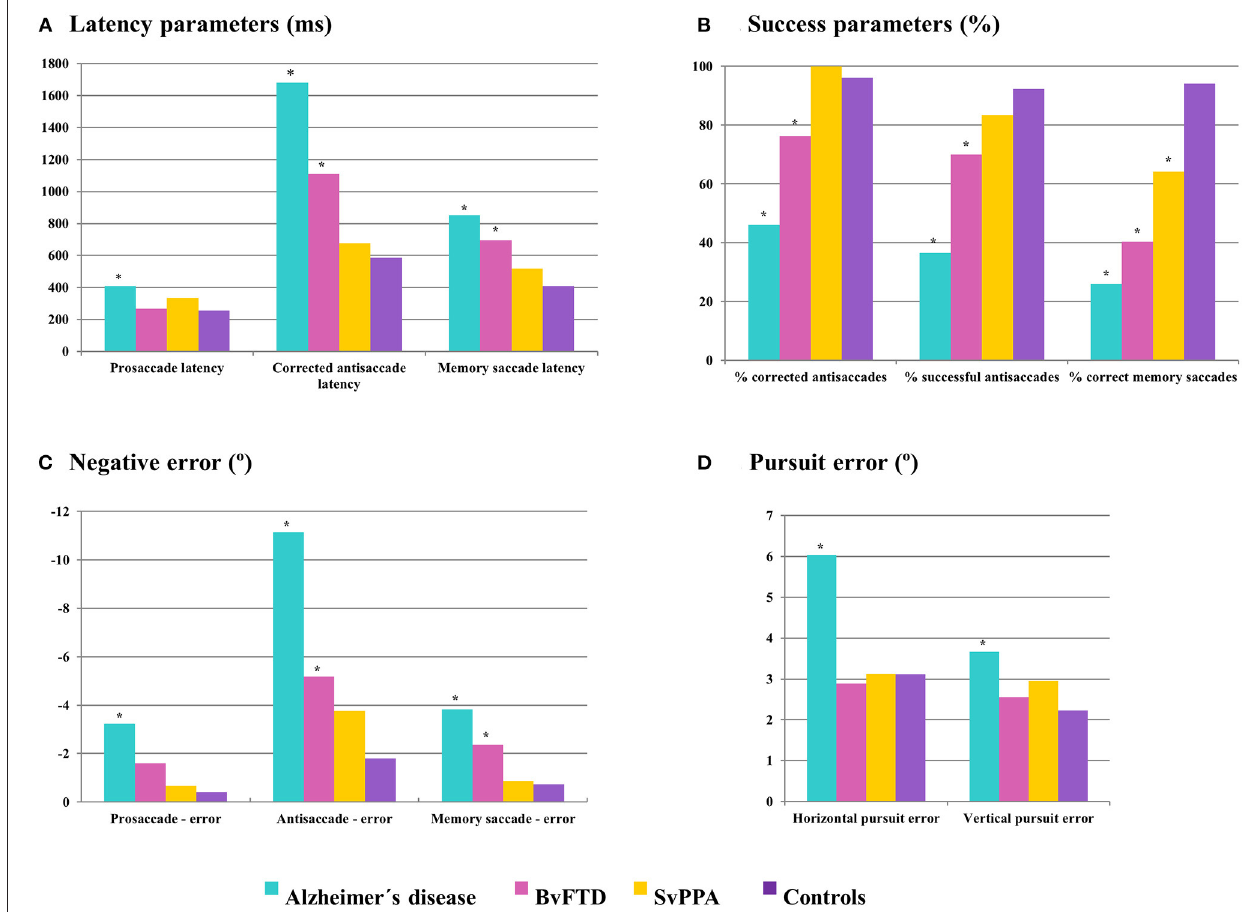
FIGURE 3 | Performance of controls and dementia groups in oculomotor parameters related to time (A) , success (B) , and spatial accuracy (C,D). Asterisks mark those dementia groups which show significant differences ( P < 0.05) compared to controls. ms, milliseconds; ◦ , degrees.